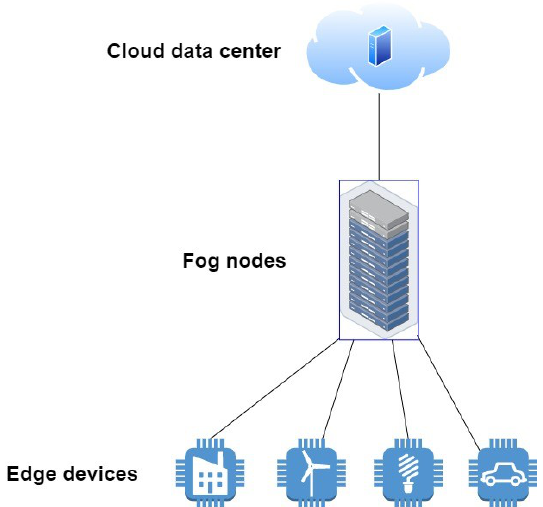
Figure 2. Cloud, fog and edge